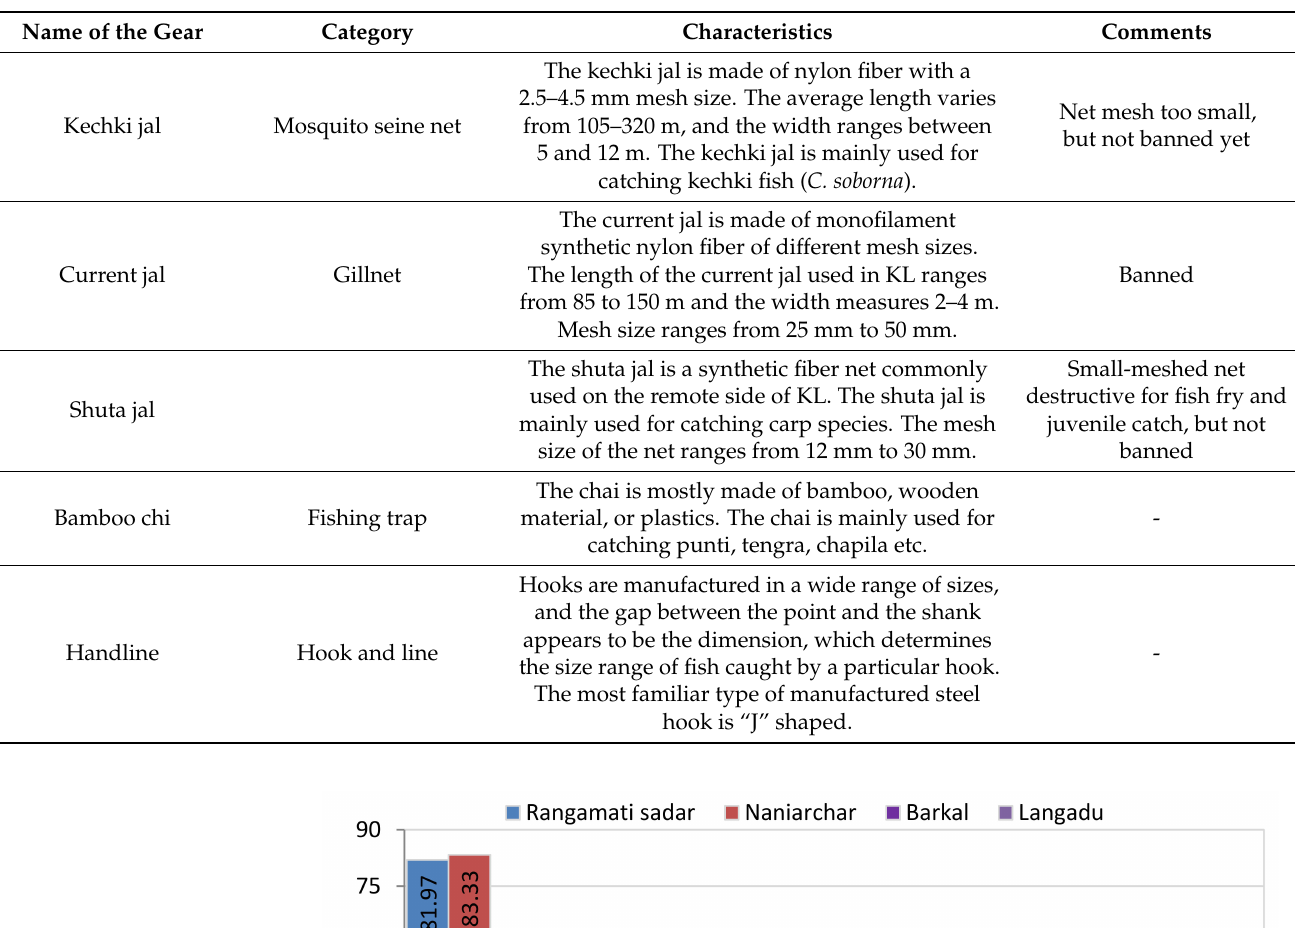
Table 6. Fishing equipment used in Kaptai Lake.